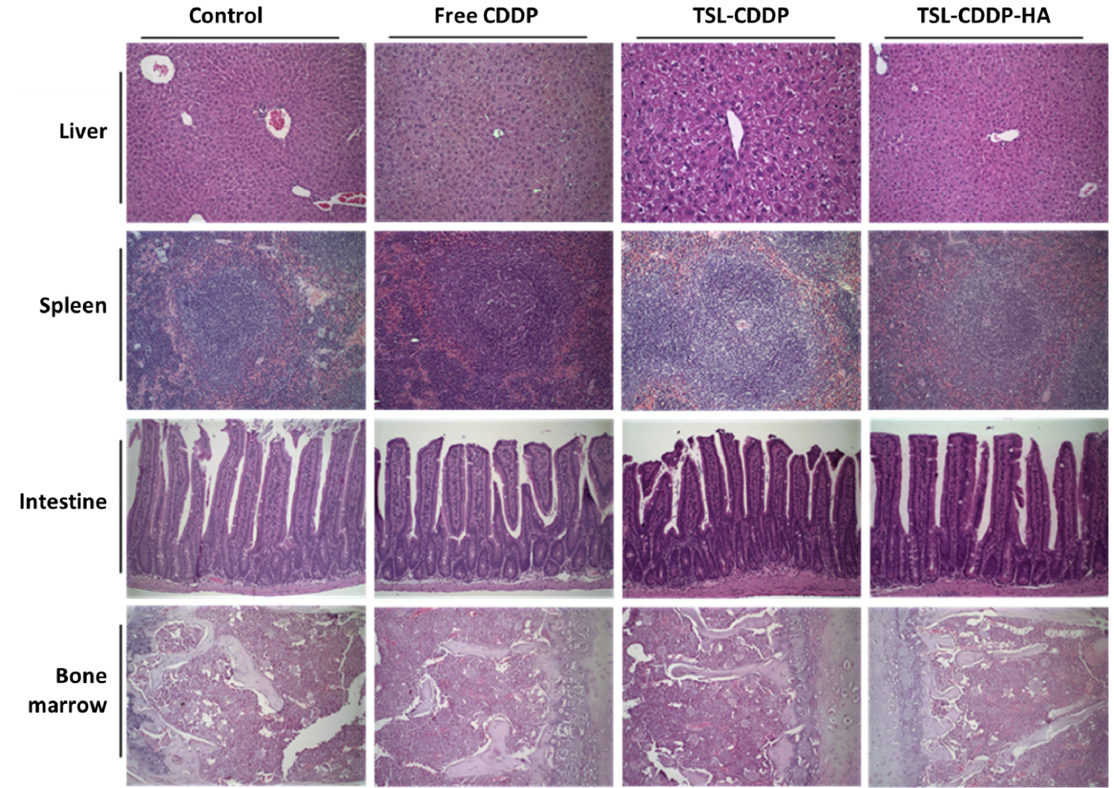
Figure 4. Photomicrographs of liver, spleen, intestine and bone marrow from Swiss mice treated with saline (control), free CDDP, TSL-CDDP and TSL-CDDP-HA. Hematoxylin & eosin staining. 20× magnification.